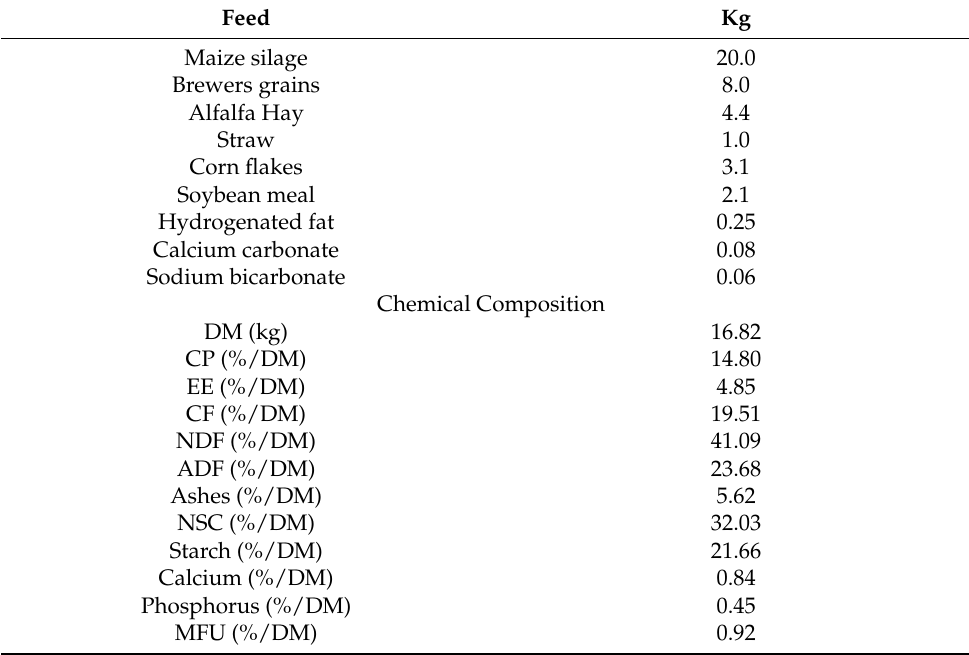
Table 1. Composition (kg), chemical characterization (% of dry matter, DM), and energy density (Milk Forage Unit—MFU) of the diet utilized during the